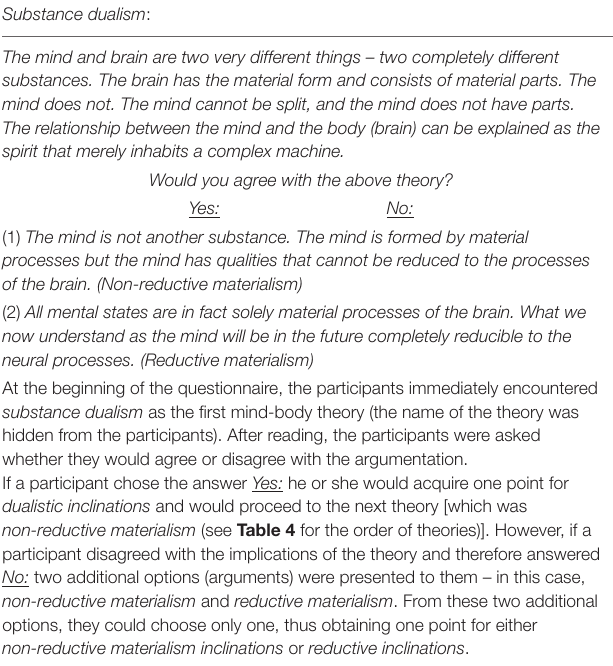
TABLE 5 | An example of description of the mind-body theory ( Substance dualism ) and